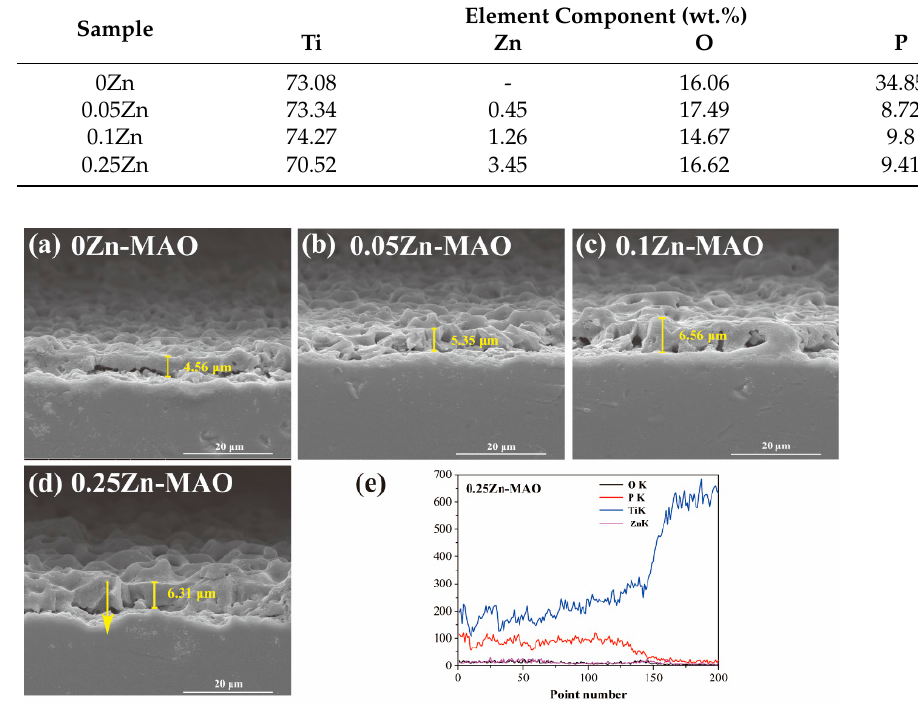
Figure 3. Cross-sectional SEM morphologies of 0Zn-MAO ( a ), 0.05Zn -MAO ( b ), 0.1Zn-MAO ( c ), and 0.25ZN-MAO ( d ) coatings, and EDS line-scan analysis crossing the yellow arrow marked in Zn-doped coatings in ( e ).